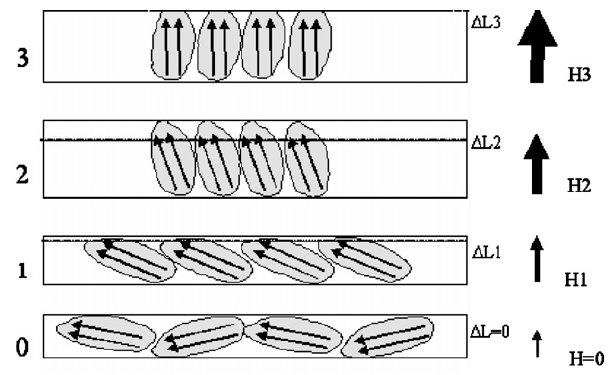
Figure 2. Schematic diagram of magnetostriction.